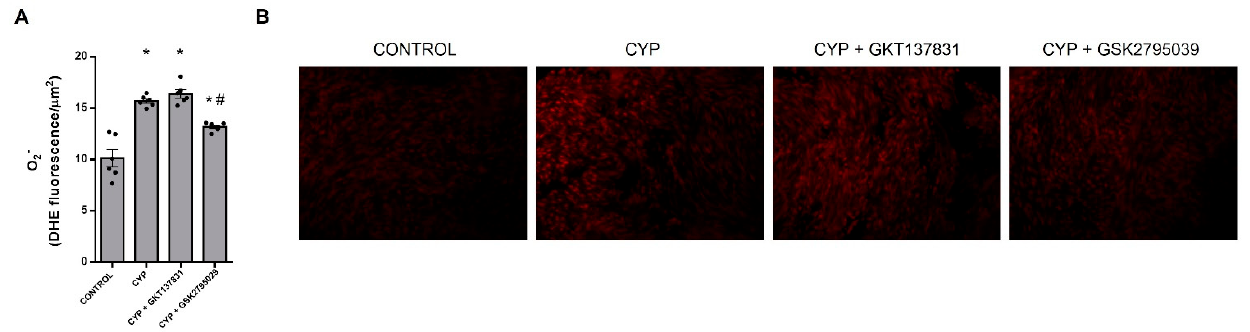
Figure 7. Superoxide anion (O 2- ) levels evaluated by dihydroethidium (DHE) fluorescence assay in bladders sections from control (saline) and cyclophosphamide (CYP, 300 mg/Kg, ip, 24 h)-injected animals untreated or treated (3 doses in 24 h) with the NOX1/4 inhibitor GKT137831 (5 mg/Kg, ip) or NOX2 inhibitor GSK2795039 (5 mg/Kg, ip). Fluorescence intensity, quantified by using ImageJ, and representative images from each group are shown in ( A , B ), respectively. Summary data (mean ± SEM) represent n = 6 for all groups. Significance was tested by two-way ANOVA followed by multiple comparisons by Tukey test. ∗ p < 0.05 vs. CONTROL; # p < 0.05 vs. CYP.